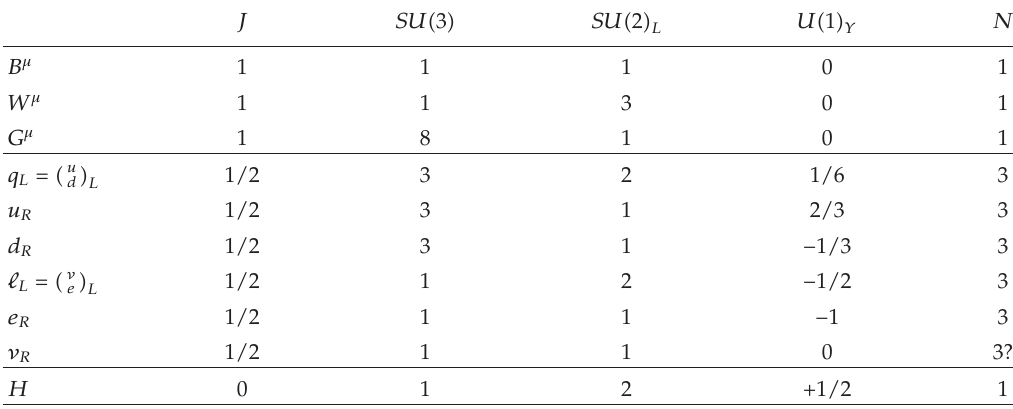
Table 1: Field content of the Minimal Standard Model. All the fermions are represented by a Left-Handed or a Right-Handed chiral field, with di ff erent quantum numbers. Specified is also the number N of di ff erent species having the same quantum numbers. The 3 copies of fermions are referred to in the text as families . The neutrino singlet ν R is a hypothetical particle, such as is the Higgs H